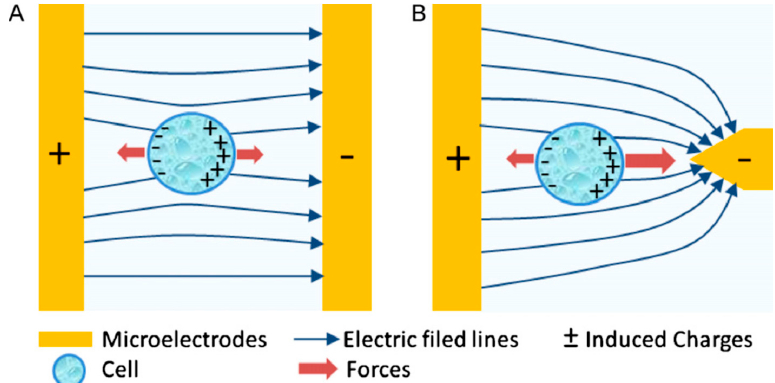
Figure 1. Diagram of the positive dielectrophoresis (pDEP) principle. Reproduced with